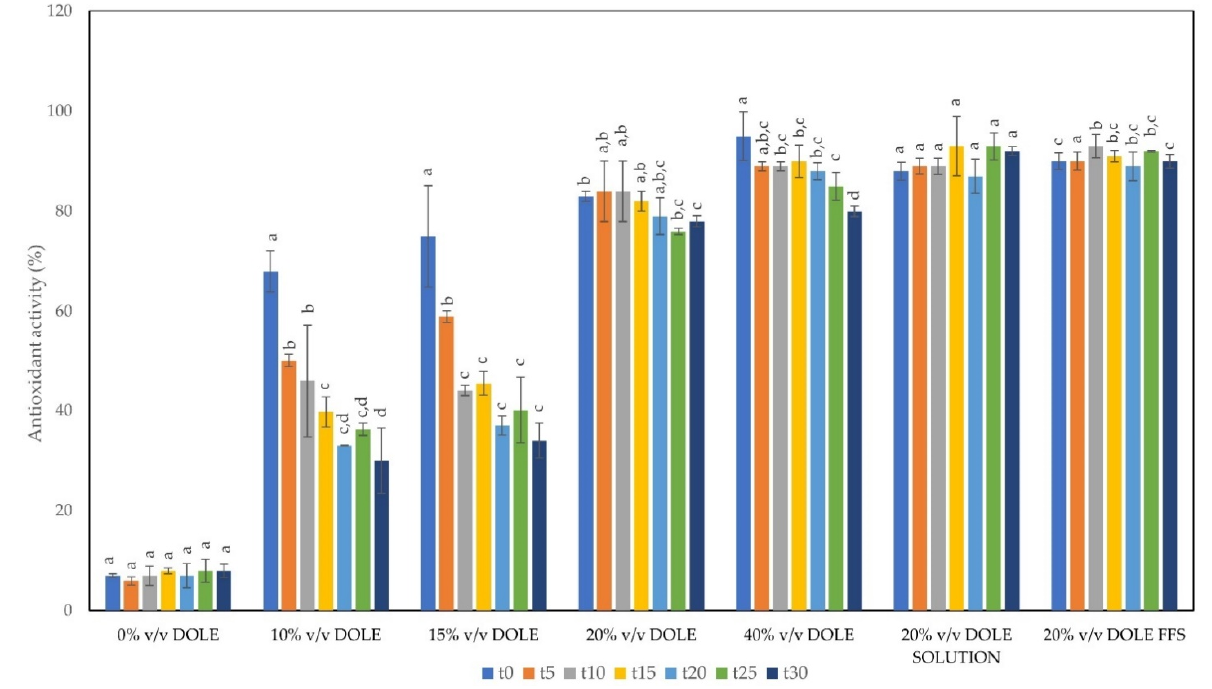
Figure 3. Antioxidant activity by DPPH assay of solubilized films (DOLE 0-10-15-20-40% ( v / v )), 20% ( v / v ) DOLE solutions, and 20% ( v / v ) DOLE Film Forming Solutions (FFS) at different days of storage. Different small letters (a–d) indicate significant differences among the values reported in each bar ( p < 0.05).